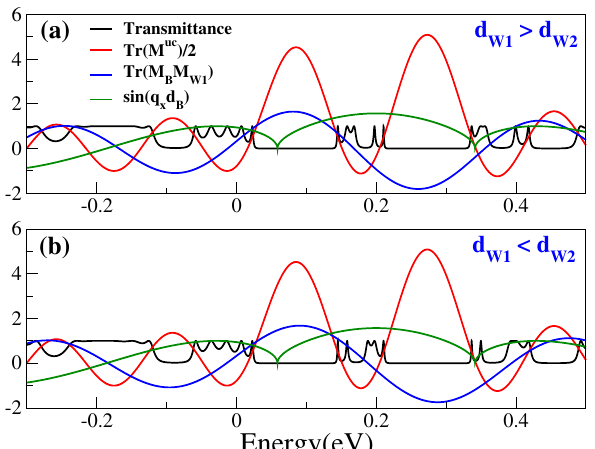
Figure 10. ( a ) Transmittance, trace of the biperiodic unit-cell Tr ( M uc )/ 2 , trace of the first barrier and well sin ( q Tr ( M x d B ) as a function of the energy for BPGGSLs with d W 1 > d W 2 . The angle of incidence is B M W 1 ) and θ = 45 ◦ . The other superlattice parameters are the same as in Fig. 2. ( b ) The same as ( a ) but for d W 1 < d W 2 . The superlattice parameters are the same as in Fig. 3.